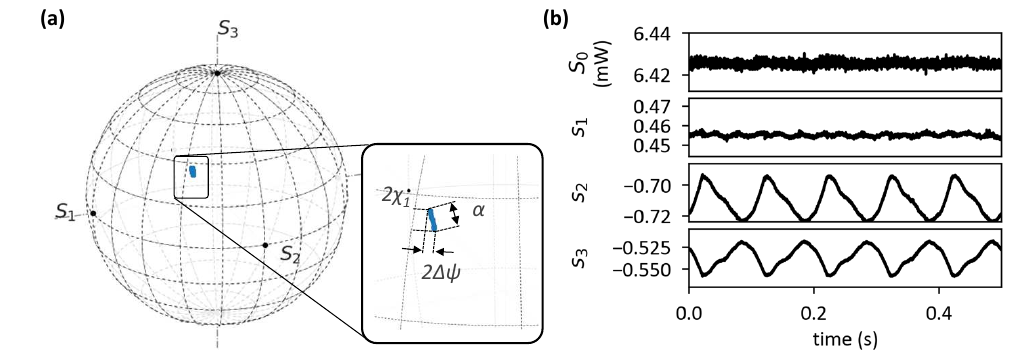
Figure 4. ( a ) A block diagram of the set-up used to characterize the vibration response of the metal tube attached to the shaker. ( b ) Configuration to investigate the effect of a displacement change for a constant acceleration of 80 m/s 2 . ( c ) Configuration to investigate the effect of acceleration change in constant displacement of 20 mm.